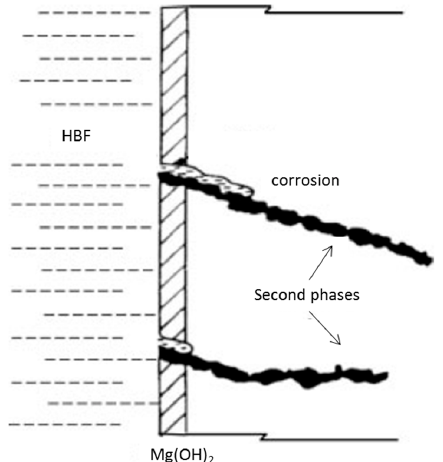
Figure 6. Preferential corrosion of Mg matrix along the precipitates. Modified from [75].